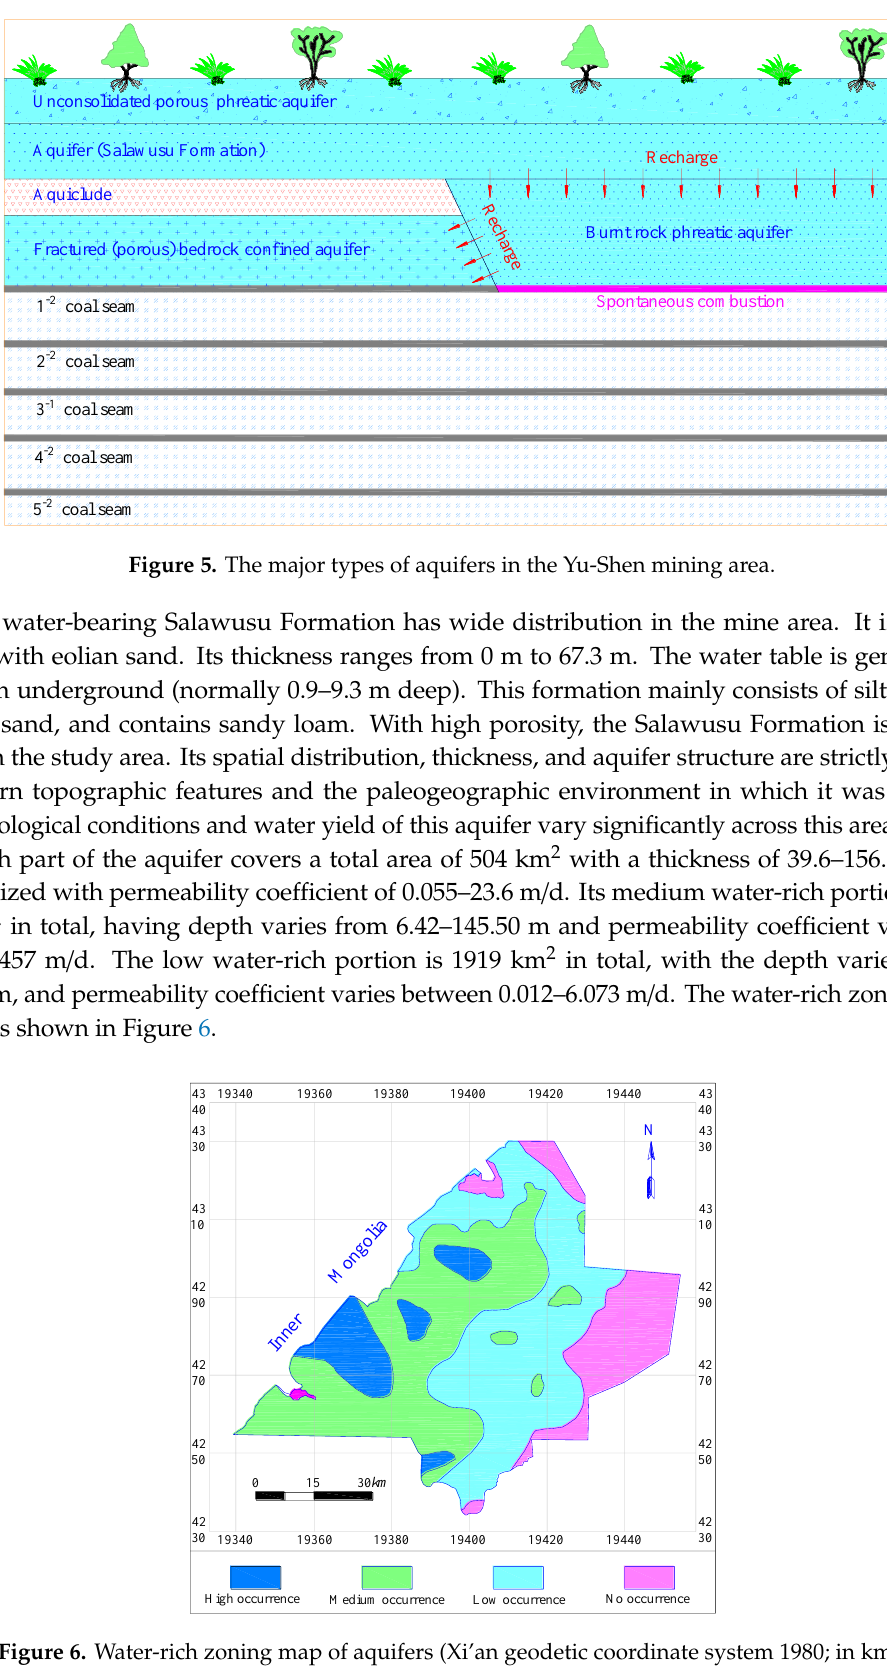
Figure 6. Water-rich zoning map of aquifers (Xi'an geodetic coordinate system 1980; in km).